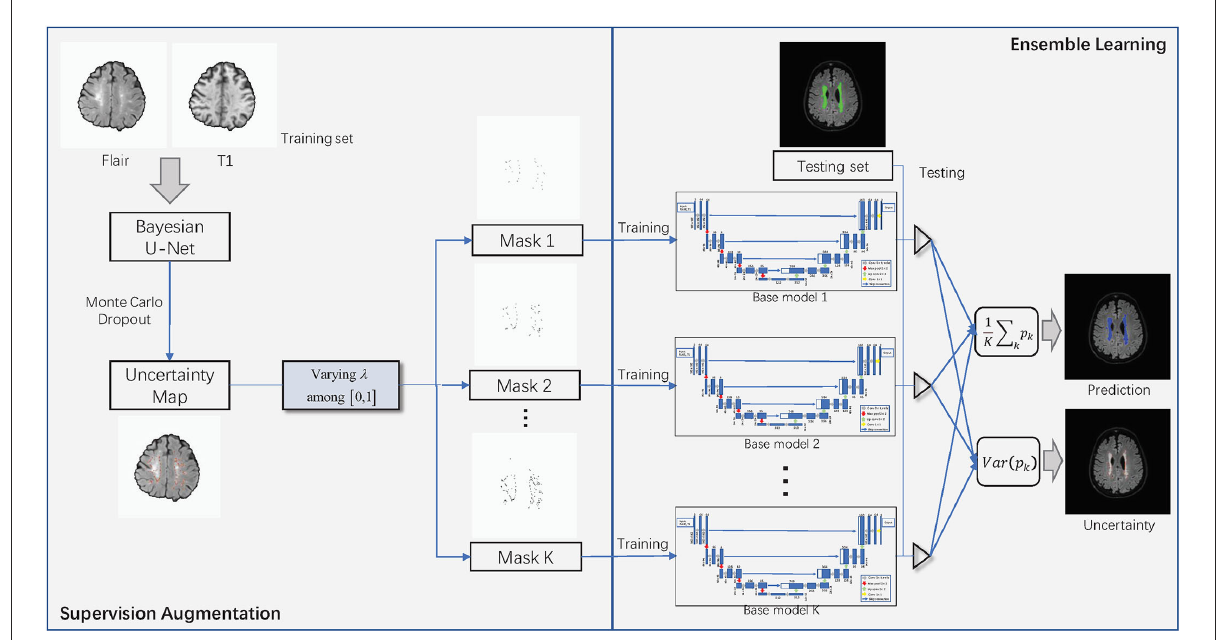
FIGURE2 The overall structure of SA-EN. It consists of two parts: supervision augmentation and ensemble